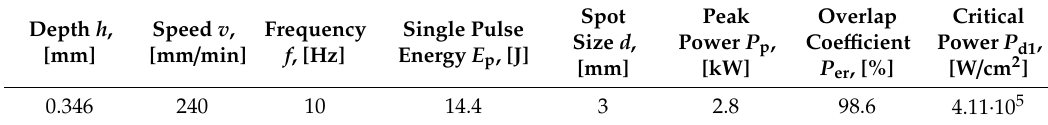
Table 4. Parameters of local laser treatment.